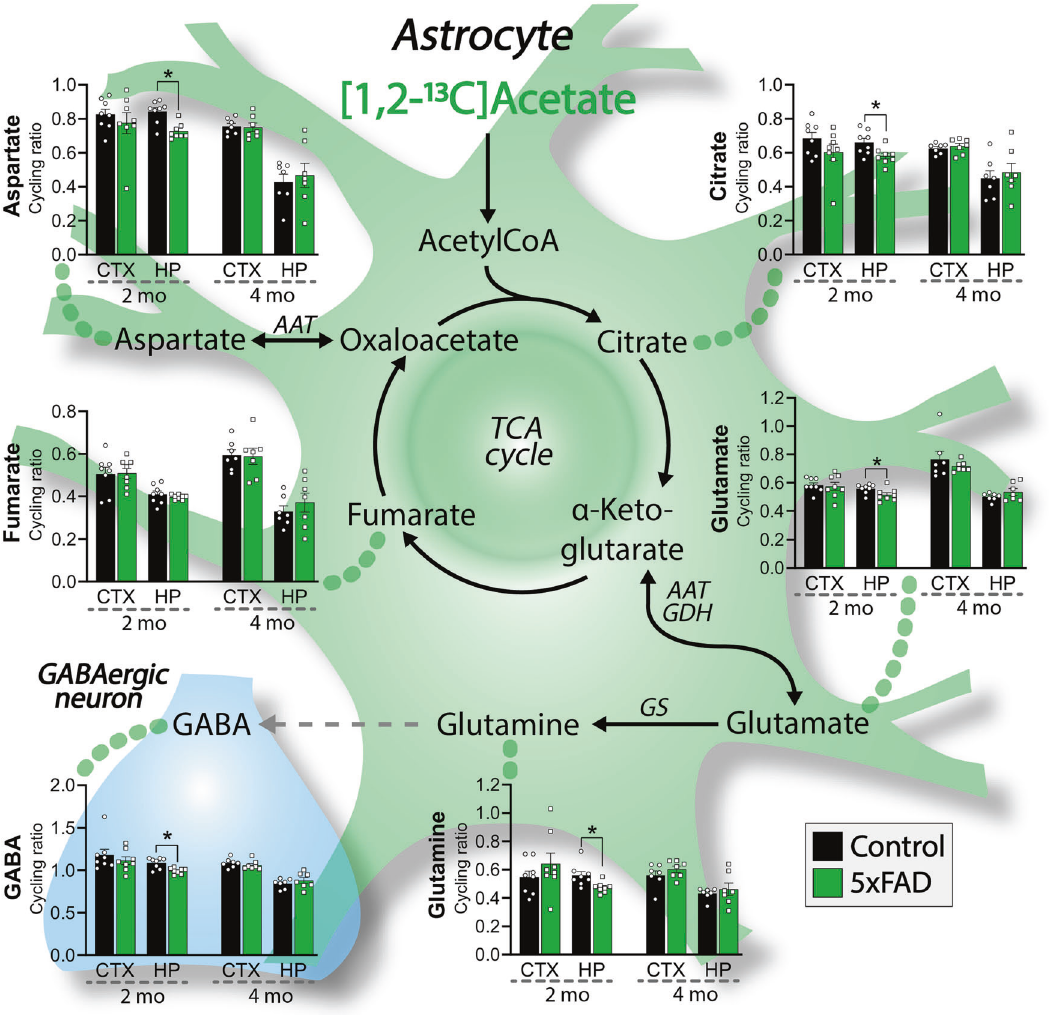
Fig. 4 Hampered astrocyte metabolism and glutamine synthesis in 5xFAD hippocampal brain slices. Cycling ratios, re fl ecting the rate of the TCA cycle, calculated from metabolism of [1,2- 13 C]acetate in acutely isolated cerebral cortical and hippocampal brain slices of 2 and 4 months (mo) old 5xFAD mice. [1,2- 13 C]Acetate is predominantly metabolized in astrocytes. Astrocytes synthesize glutamine, which is essential for the replenishment of the neuronal GABA pools. AAT: aspartate aminotransferase, CTX: cerebral cortex, GAD: